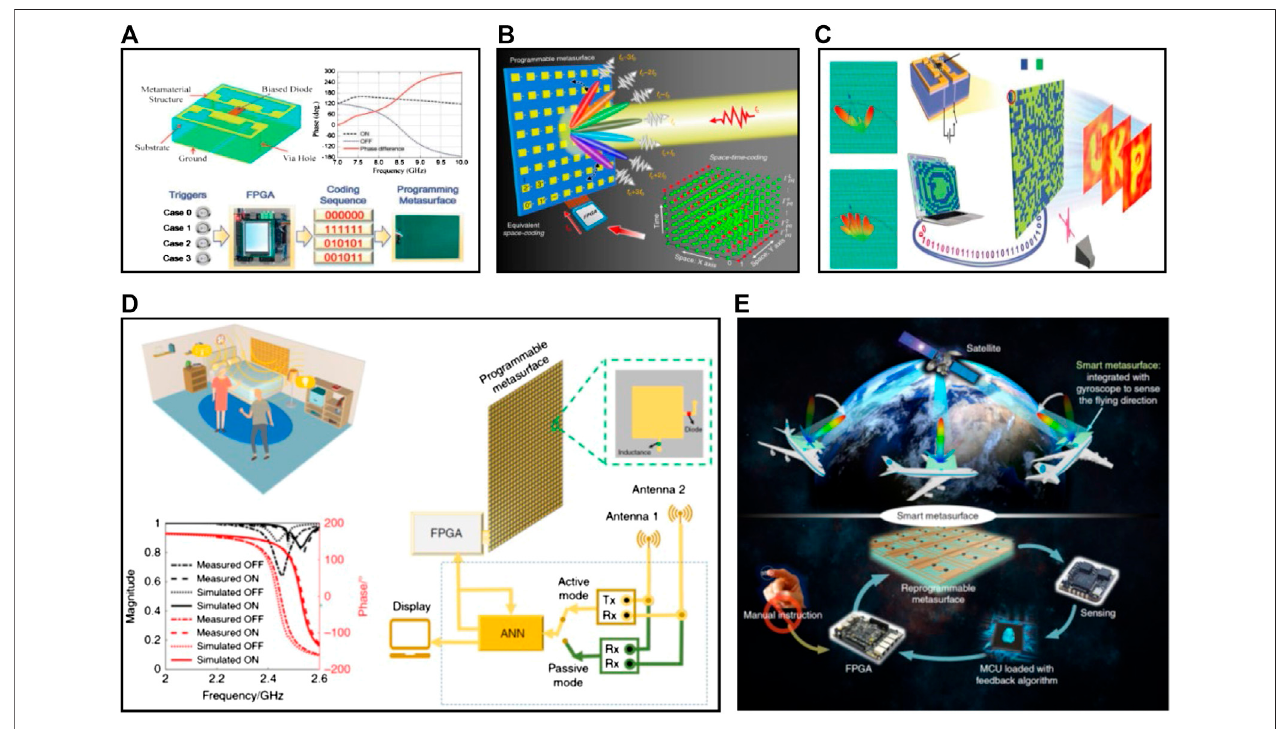
FIGURE 5 | Coding and programmable metasurface structure and its application. (A) Basic programmable metasurface [99], (B) space-time modulated digital coding metasurface [127], (C) recon fi gurable holographic imaging metasurface [128], and (D) , (E) smart metasurface [129, 130].